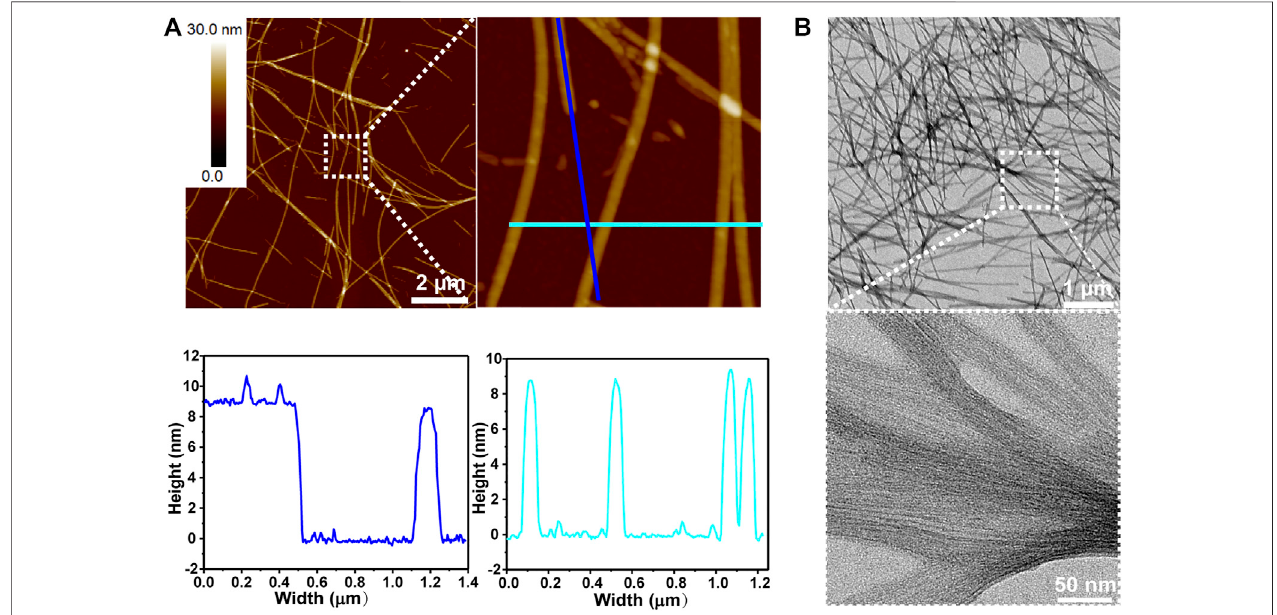
FIGURE2| Peptidenanowirestructuresco-assembledbyKK-11andKKd-11inaconcentrationratioof1:1. (A) AFMimages (upper) andlinearsectionanalysisof the colored lines shown in AFM image (lower) . (B) TEM images.